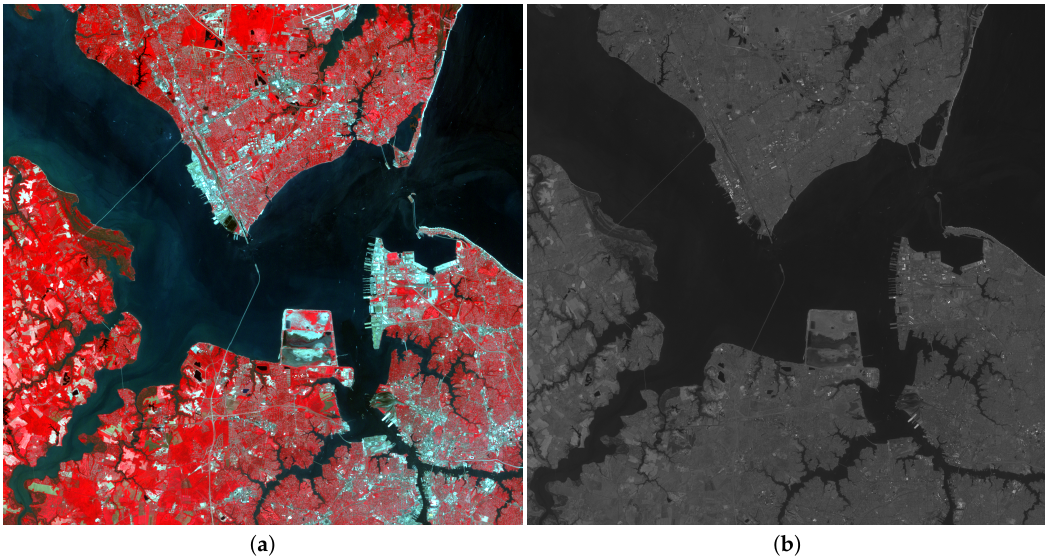
Figure 1. Observed LANDSAT 7-ETM+ Chesapeake Bay image: ( a ) 1024 × 1024 multispectral (MS), ( b ) 2048 × 2048 panchromatic